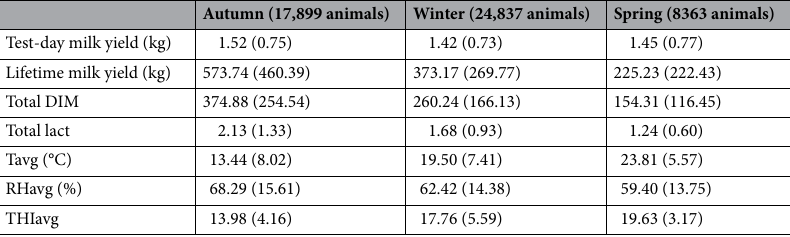
Table 1. Descriptive statistics (mean and SD in parentheses) of animal performance and weather variables by lambing season. Total DIM: Total number of days milked, Total lact: Total number of lactations milked, Tavg: average air temperature, RHavg: average relative humidity, THIavg: average temperature-humidity